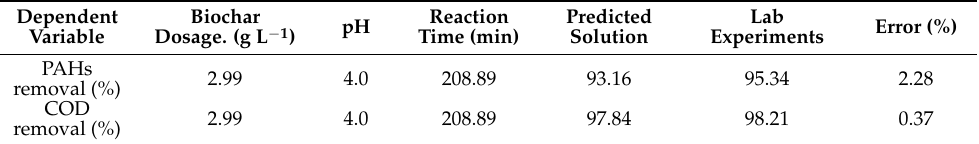
Table 5. Response results of the experiment and prediction model for optimal mix design.